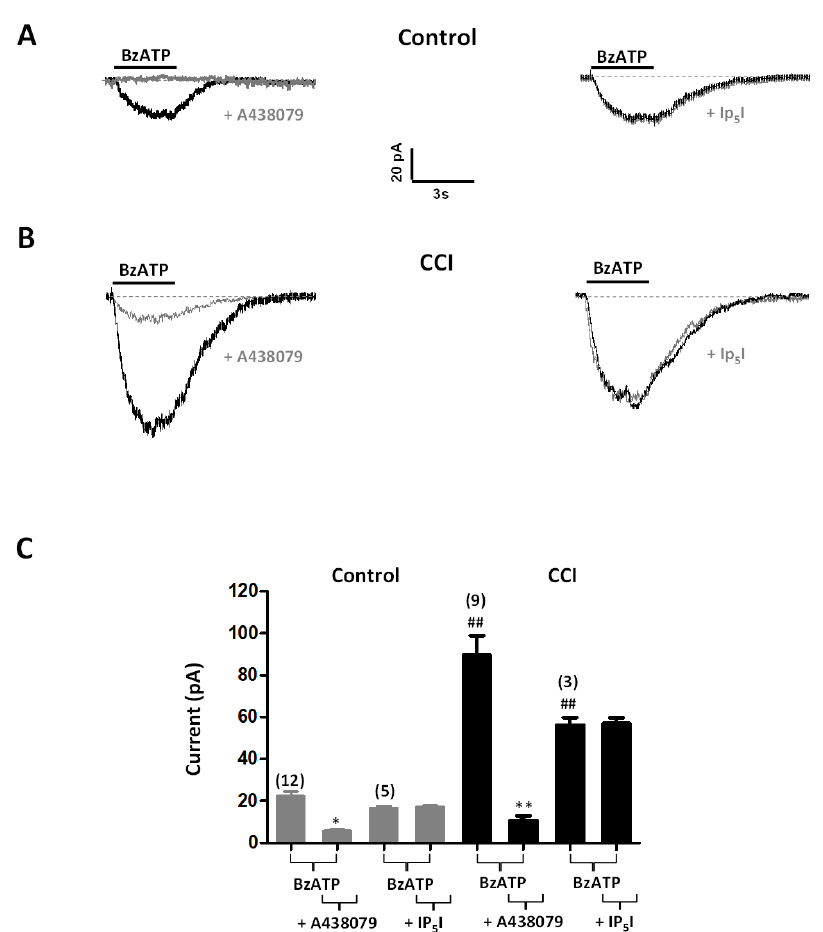
Figure 7. Functional plasticity of P2X7 receptors in chromaffin cells from CCI animals. ( A ) Voltage-clamp recordings of currents evoked by BzATP (a P2X7 receptor agonist) in chromaffin cells of the adrenal gland from Control animals. The horizontal bars show the application of BzATP (100 µM, 3 s), which was applied twice with a 10 min interval in the absence or the presence of A438079 (+A438079; 10 µM, 2 min; left panel) or of Ip 5 I (+Ip 5 I; 10 µM, 2 min; right panel). ( B ) Similar to panel ( A ), but referred to CCI animals. Scale bars apply to panels ( A,B ). ( C ) Amplitudes of 100 µM BzATP- Ip 5 I ((+Ip 5 I; 10 µM) or A438079 (+A438079; 10 µM). Data from the number of cells are shown between parentheses on top of bars. Statistical significances were assessed by a Student t test for paired data evaluating the effect of CCI ( ## , p < 0.01).